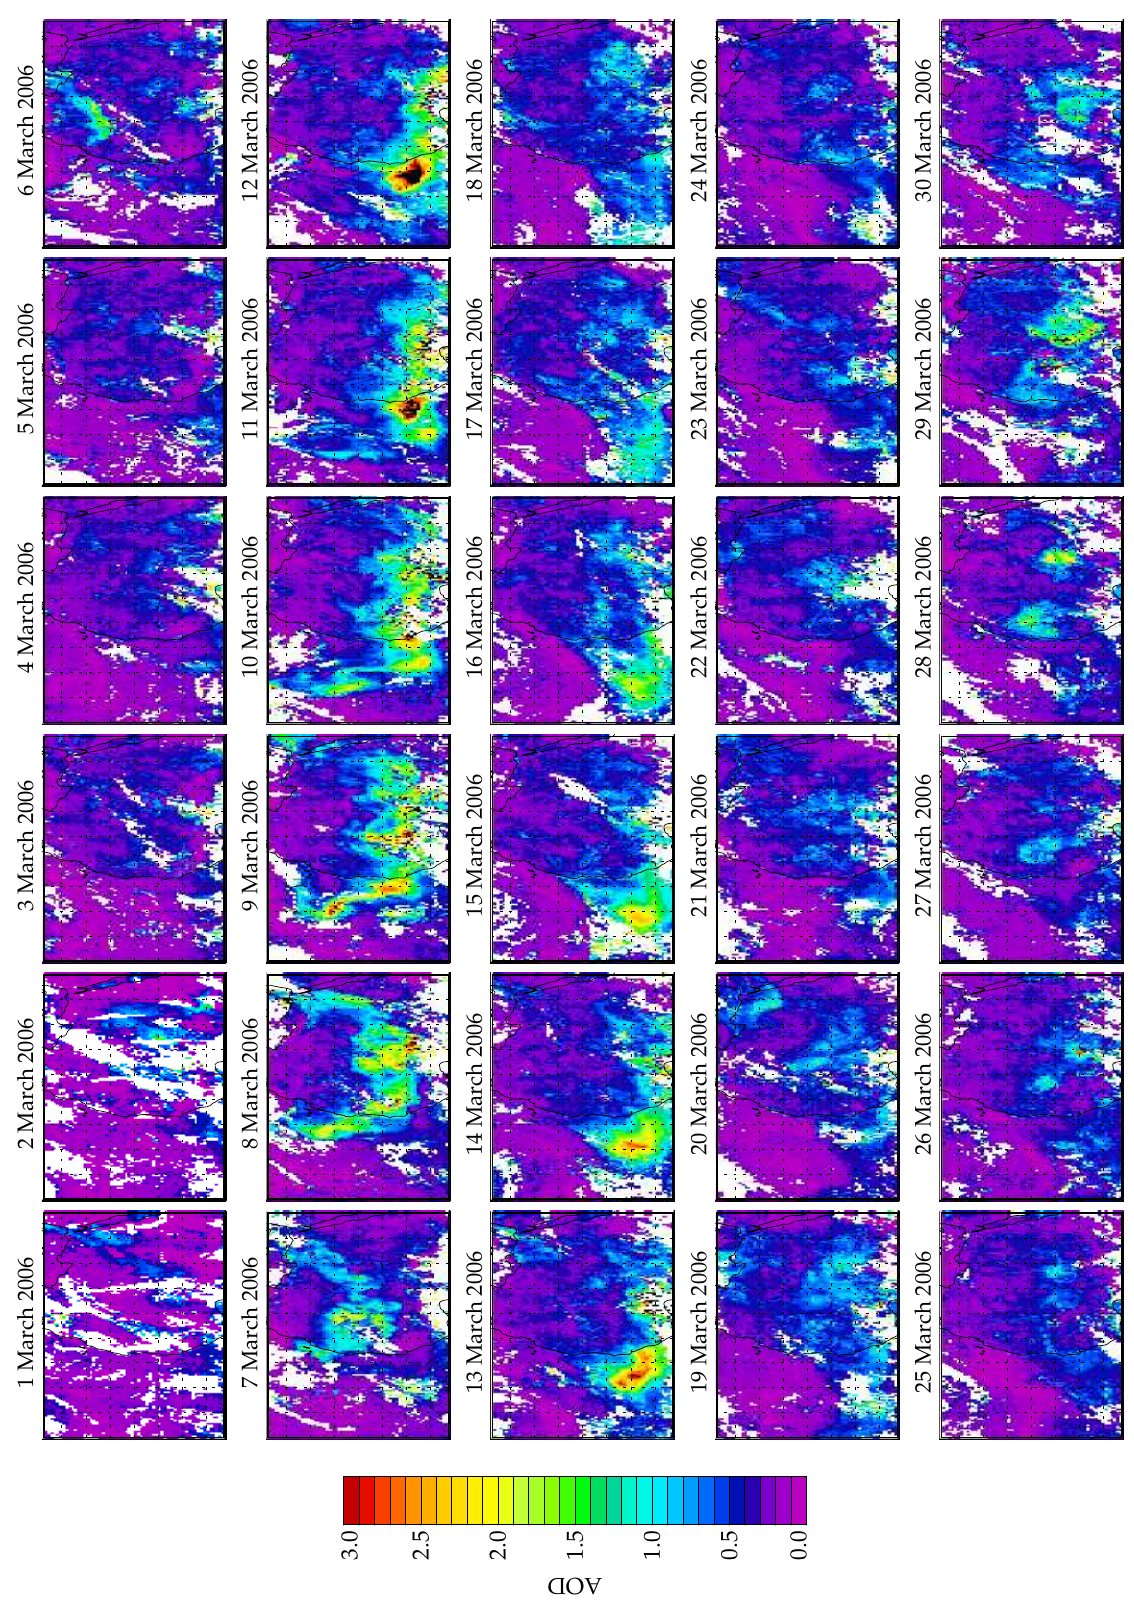
Fig. 10. Combined daily AOD for the first 30 days of March, 2006.